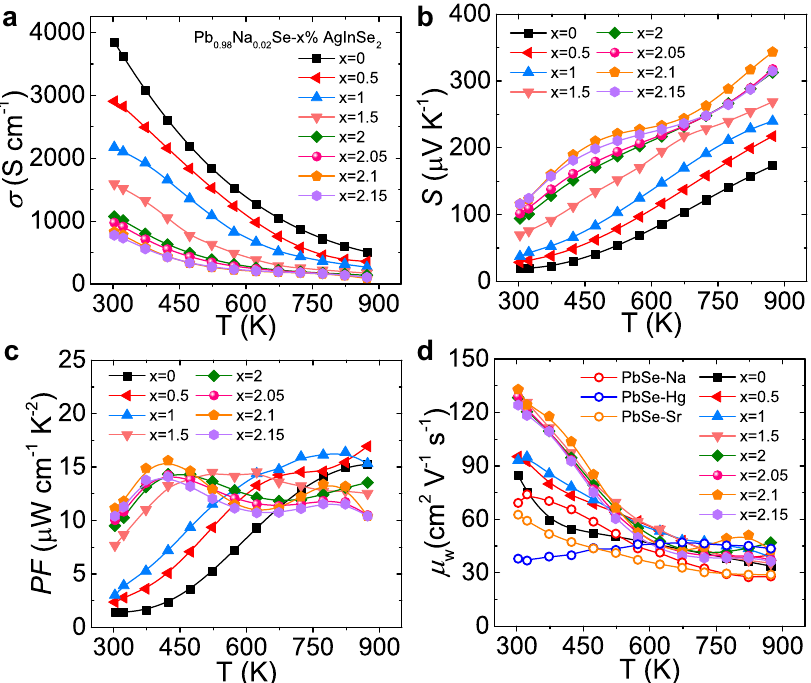
Fig. 3 Electrical properties as a function of temperature for Pb 0.98 Na 0.02 Se − x % AgInSe 2 (LISS) compounds. a Electrical conductivity. b Seebeck coef fi cient. c Power factor. d Weighted mobility. The hollow circles in d represent the weighted mobility of single-band and two-band PbSe-based